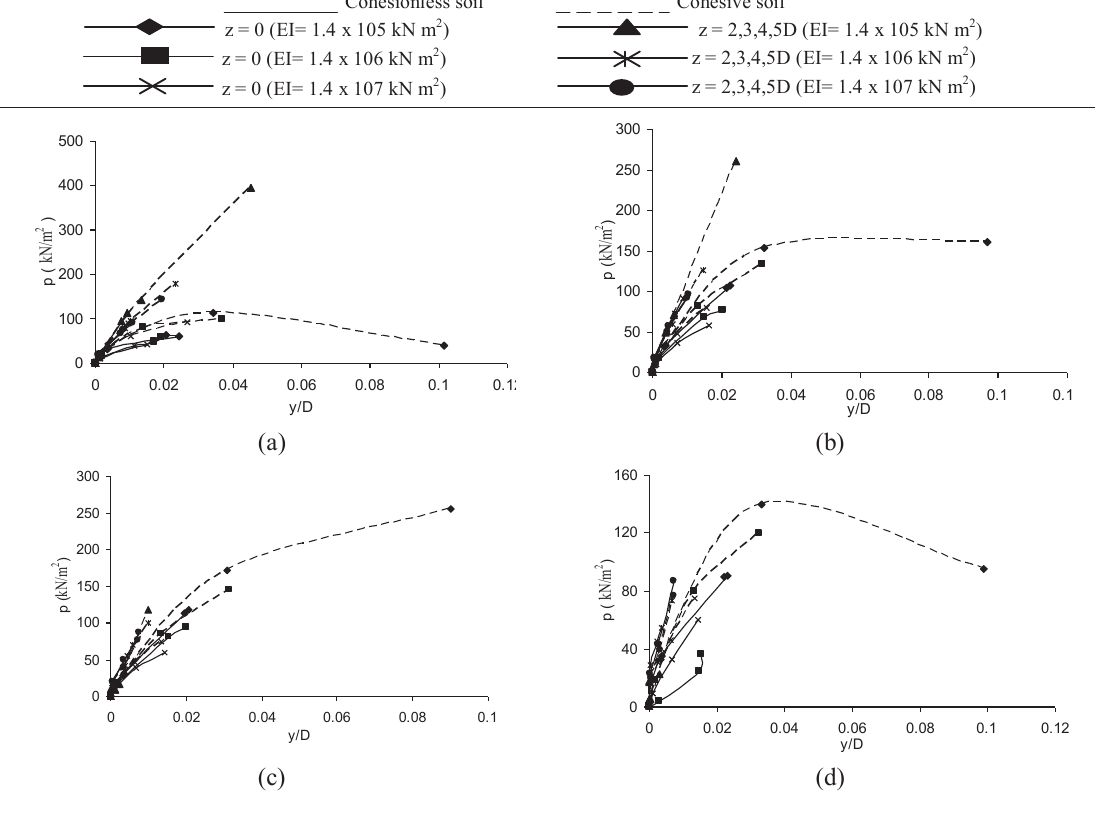
Figure 13 p – y curves predicted under the effect of pile stiffness, EI , and pile slenderness ratio of pile embedded on both cohesionless and cohesive